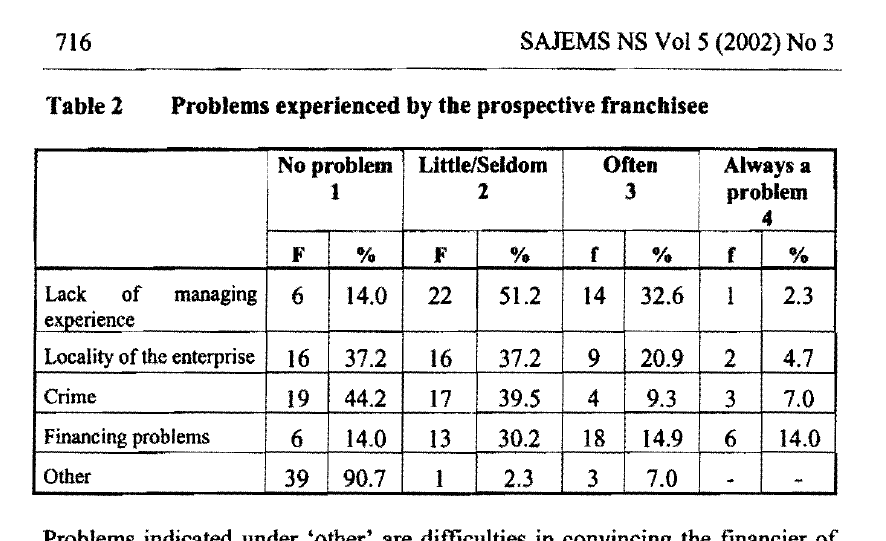
Problems experienced by tbe prospective francbisee